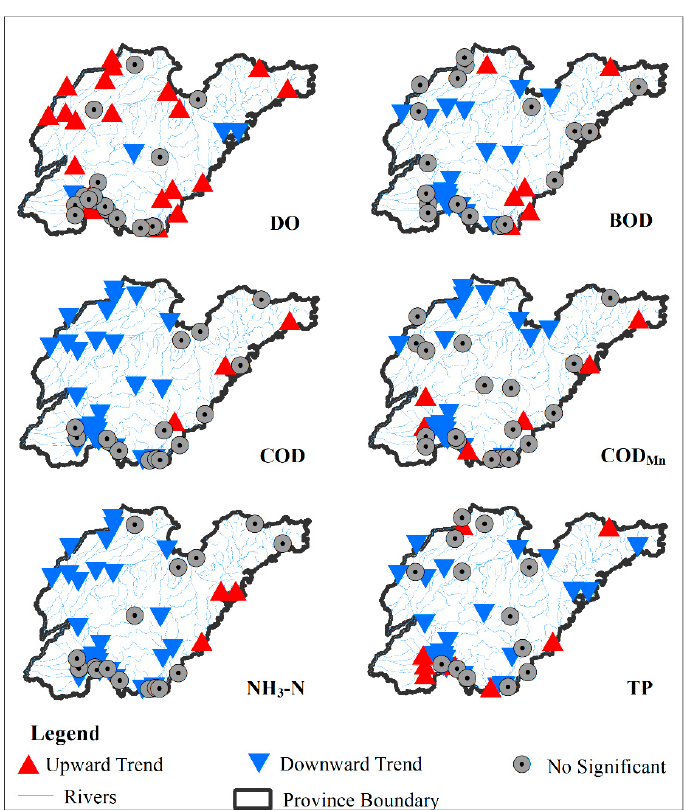
Figure 3. Temporal trends observed upon seasonal Mann-Kendall’s (SMK) testing for water quality parameters at 45 monitoring stations during 2009–2017. Table 2. Z values of Global Moran’s I spatial autocorrelation of the trend.